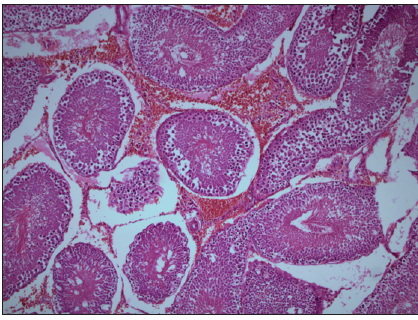
Figure 2. Hemorrhage in the interstitium, IR+Udenafil, HEx200